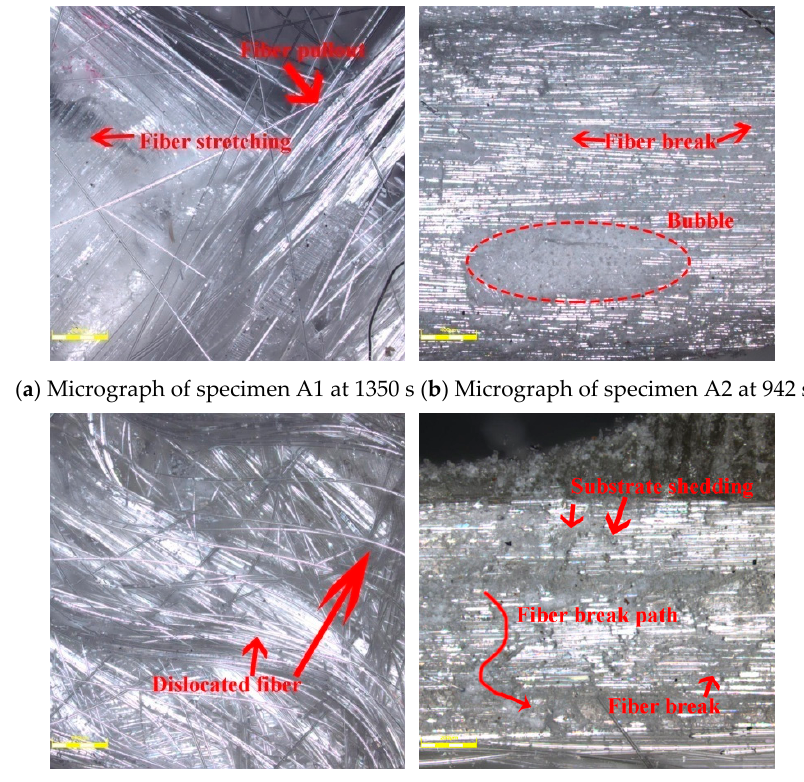
Figure 9. Micrograph of specimens when a temperature jump occurred.